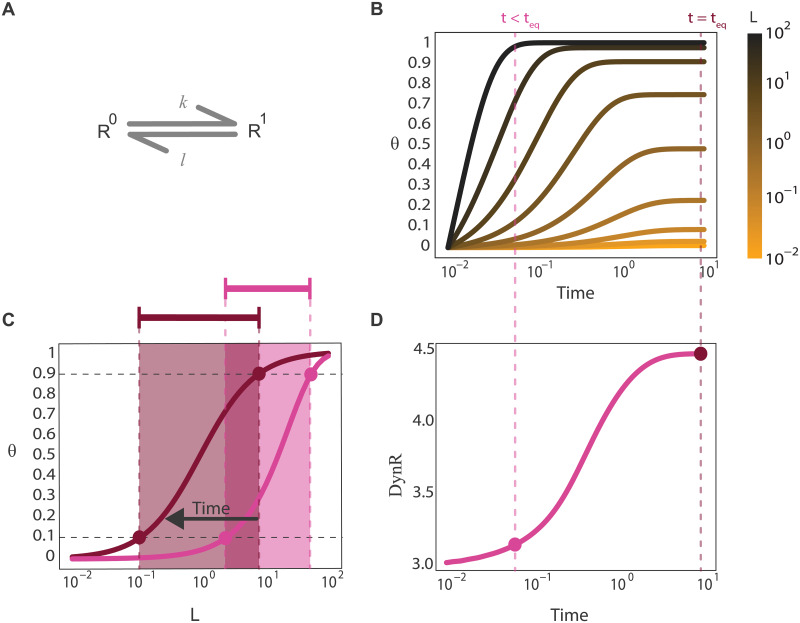
The dose-response curve evolves in time.(A). Scheme representing a receptor with a single binding site. (B). Proportion of occupied binding sites (θ) versus time for different doses (L) coded in a color scale. Two vertical dashed lines indicate pre-equilibrium and equilibrium. (C). Proportion of occupied binding sites (θ) versus dose (L) for the two times indicated in (B). EC10, EC90 and the segment going from one to the other are indicated for the two curves. (D). DynR versus time, computed as the log of EC90/EC10.